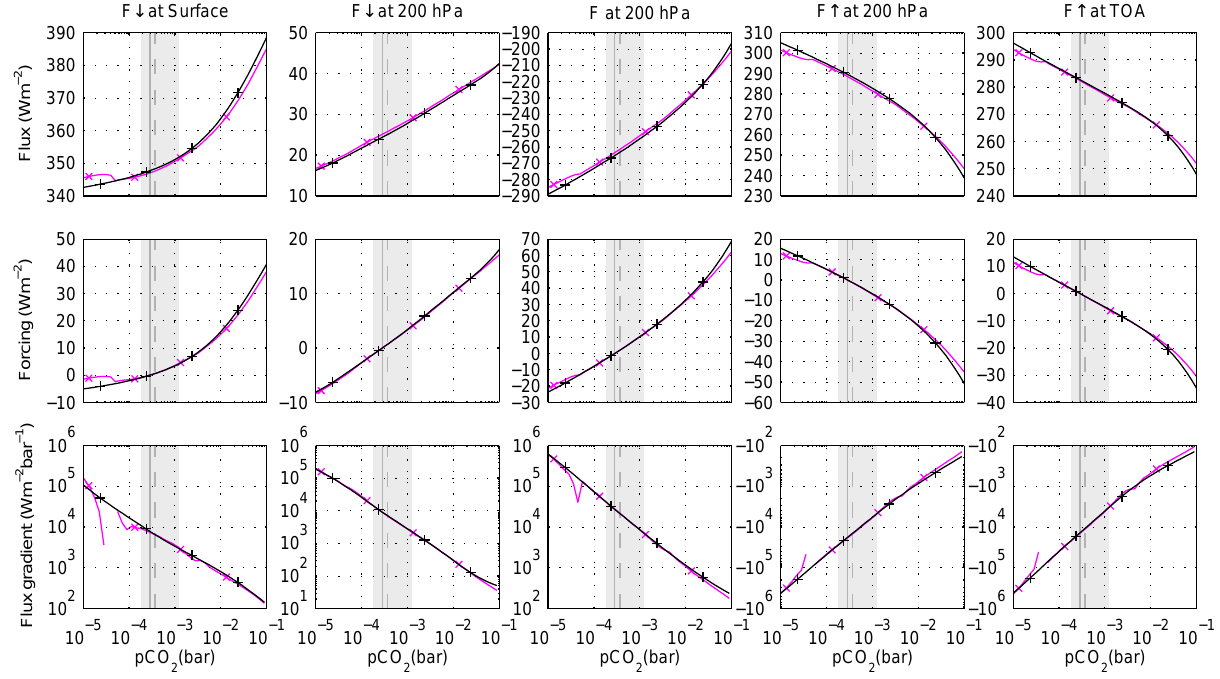
Fig. 1. RRTM performance for CO 2 for each flux and each level. Colours (online only) and markers are: black+ for LBLRTM, magenta × for RRTM. Shaded areas range from Quaternary minimum (180ppmv) to SRES maximum (1248ppmv) concentration. Grey lines in these areas are solid for pre-industrial (287ppmv) and dashed for year 2000 (369ppmv)